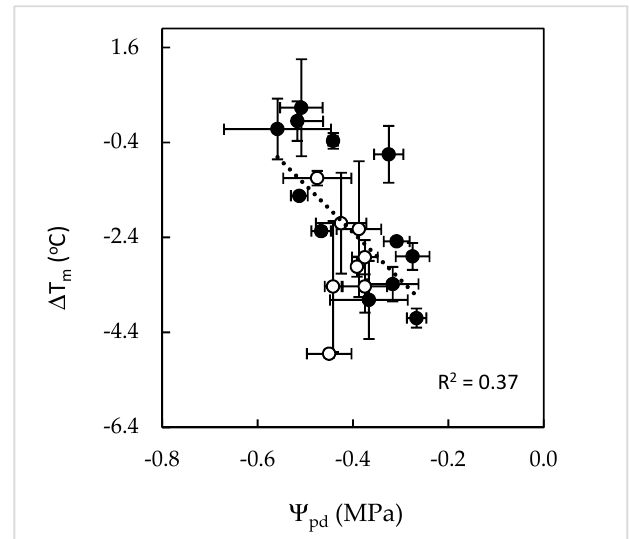
Figure 4. Relationship between the predawn water potential ( Ψ pd ) and the canopy-to-air temperature difference ( Δ T m ) in Xarel·lo field plots acquired in 2009 (open symbols) and 2010 (bold symbols) collected under clear-sky conditions. Values are means ± standard errors of the mean at each plot ( n = 8 and n = 12 for 2009 and 2010, respectively). The regression line and regression coe ffi cient are for pooled data across